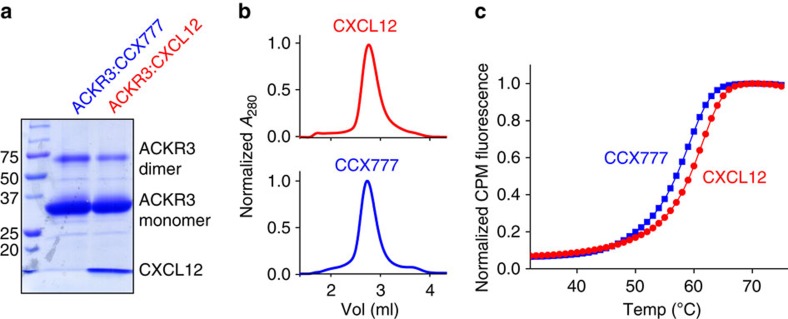
Characterization of ACKR3 complexes in DDM/CHS micelles.(a) A strong band corresponding to monomeric ACKR3 and a minor band corresponding to dimeric receptor can be seen on a 10% SDS–PAGE gel. A lower molecular weight band corresponding to CXCL12 is seen only for the ACKR3:CXCL12 complex. A full, uncropped version of the gel is shown in Supplementary Fig. 7. (b) SEC trace of ACKR3 in complex with CXCL12 and CCX777. The sharp peak eluting at ∼2.8 ml shows that both samples are monodisperse in DDM/CHS micelles. (c) Thermal unfolding of ACKR3 complexes using CPM fluorescence21. Tm values were 59 and 61 °C for ACKR3:CCX777 and ACKR3:CXCL12 complexes, respectively.